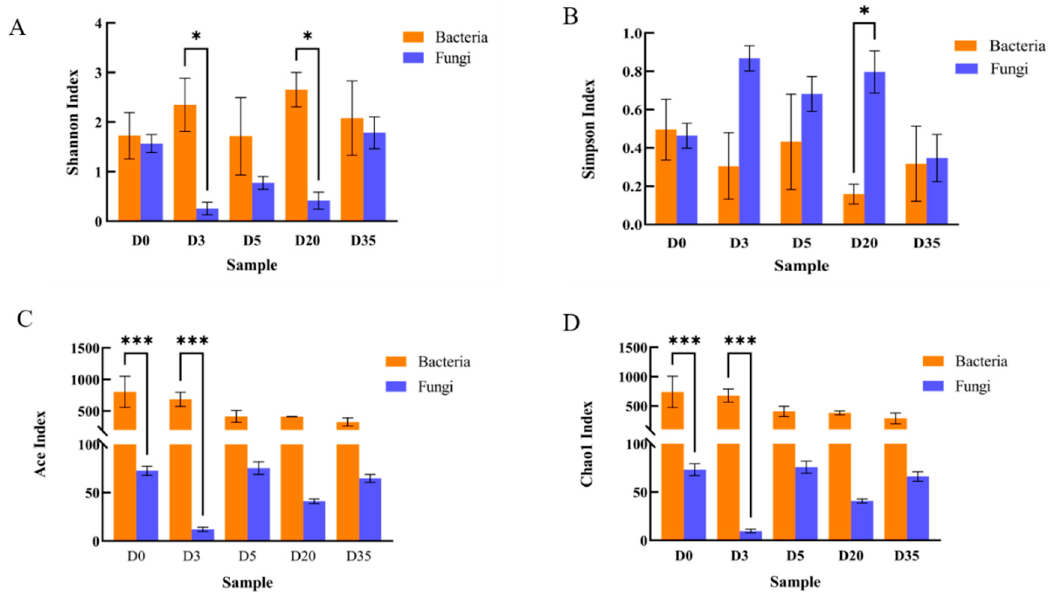
Figure 2. Alpha diversity of Douchi in different fermentation stages, ( A ): Shannon Index, ( B ): Simpson Index, ( C ): Ace Index, ( D ): Chao 1 Index (***: p < 0.001, *: p <